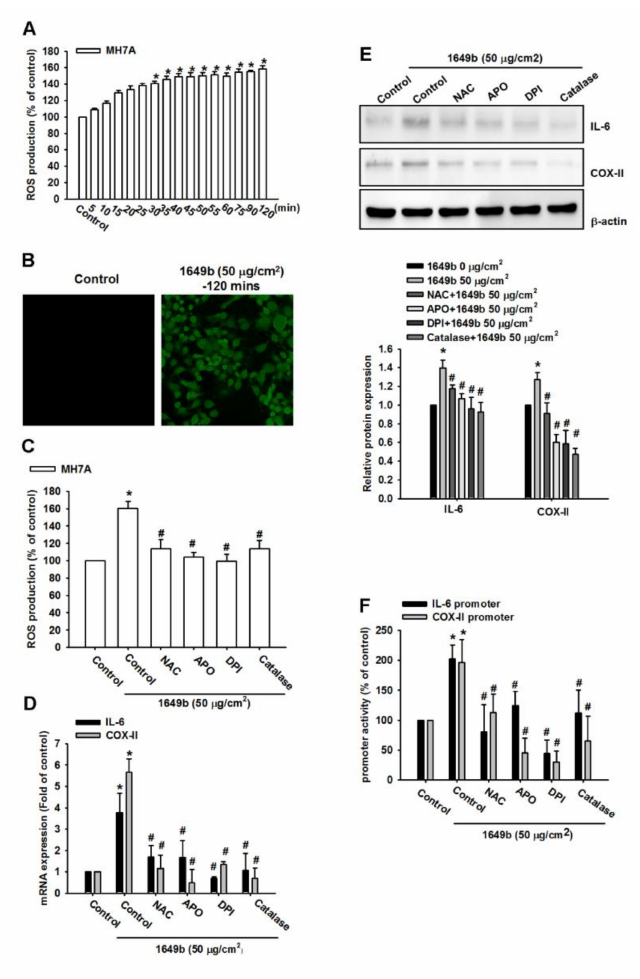
Figure 2. PMs induce the generation of reactive oxygen species (ROS) in human rheumatoid arthritis synovial fibroblasts (RASFs). ( A , B ) RA-FLS were treated with control solution or PMs (50 µ g / cm 2 ) for various times. The concentration of ROS production was examined by using flow cytometry and fluorescence image; ( C ) RA-FLS were pretreated for 30 min with N-acetylcysteine 1-mM (NAC, NADPH oxidase inhibitor), diphenyleneiodonium chloride 10 µ M (DPI, nonspecific flavoprotein inhibitor), catalase 500 units / mL (ROS scavengers) and apocynin 100 µ M (APO, NOX-like enzymes inhibitor) followed by treatment with PMs (50 µ g / cm 2 ) for 30 min. The concentration of ROS production was examined by using flow cytometry; ( D – F ) RA-FLS were treated with N-acetylcysteine 1-mM (NAC, NADPH oxidase inhibitor), diphenyleneiodonium chloride 10 µ M (DPI, nonspecific flavoprotein inhibitor), catalase 500 units / mL (ROS scavengers) and apocynin 100 µ M (APO, NOX-like enzymes inhibitor) followed by treatment with PMs (50 µ g / cm 2 ) for 24 h. The IL-6 and COX-2 expression were examined by using qPCR, western blotting and luciferase activity. The data are expressed as the mean ± SD. * p < 0.05 compared with controls. # p < 0.05 compared with the PMs treated